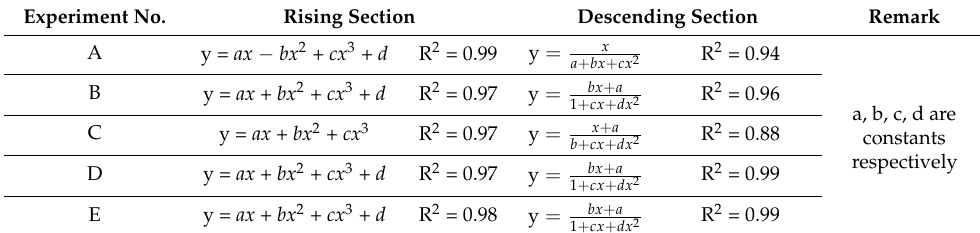
Table 4. The fitting curve formula of the stress rebound